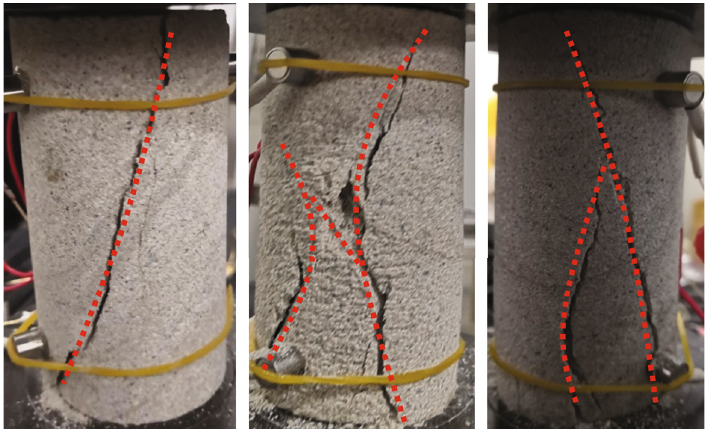
Figure 4: Failure characteristic of rock specimen under uniaxial.